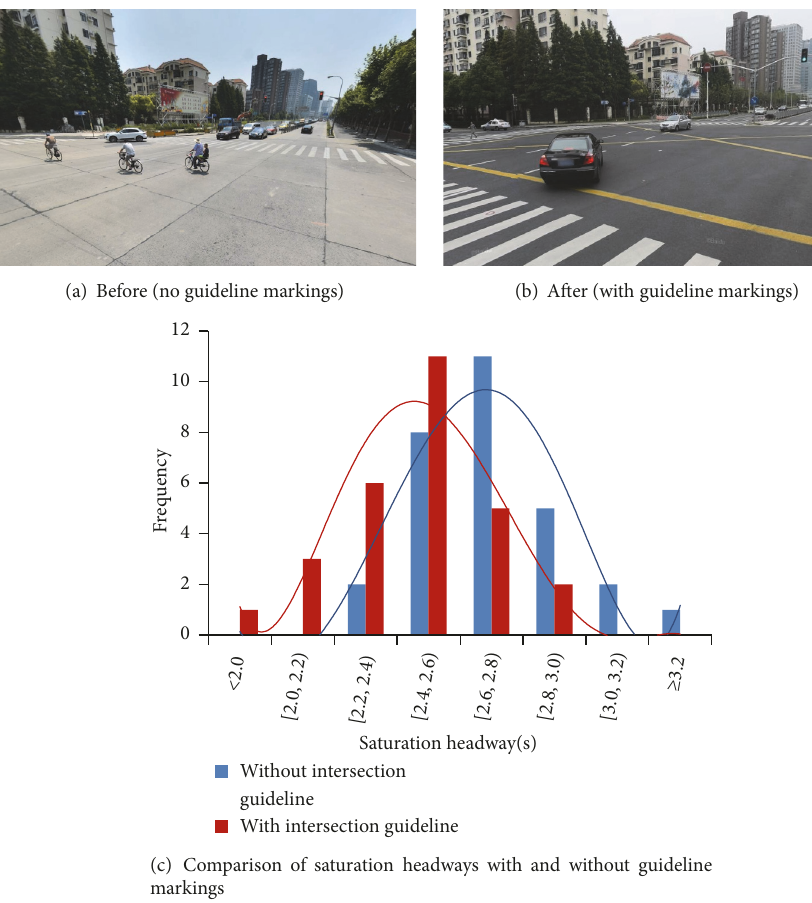
Figure 9: Mingsheng Rd. and Lingshan Rd. intersection.